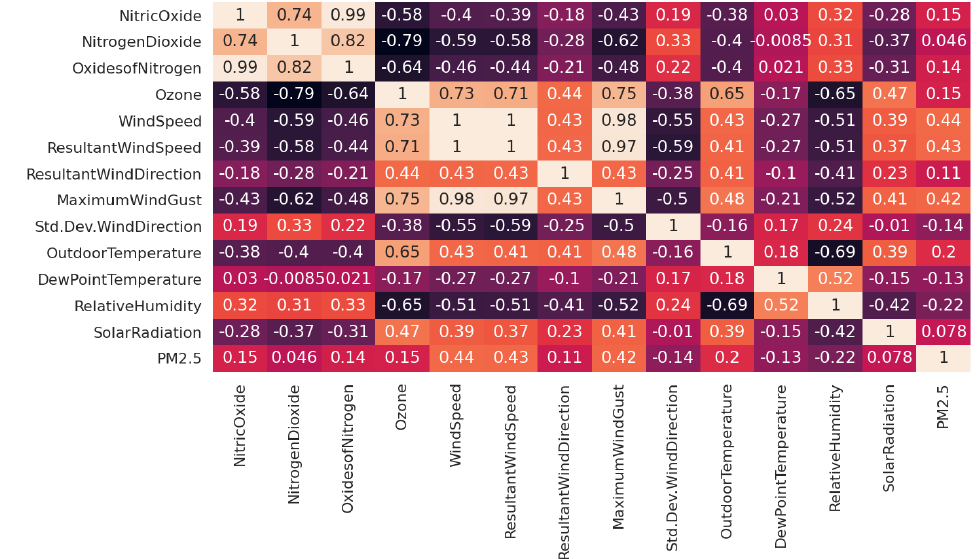
Figure 5. Correlation among the predictors with histogram of PM 2.5 data set.